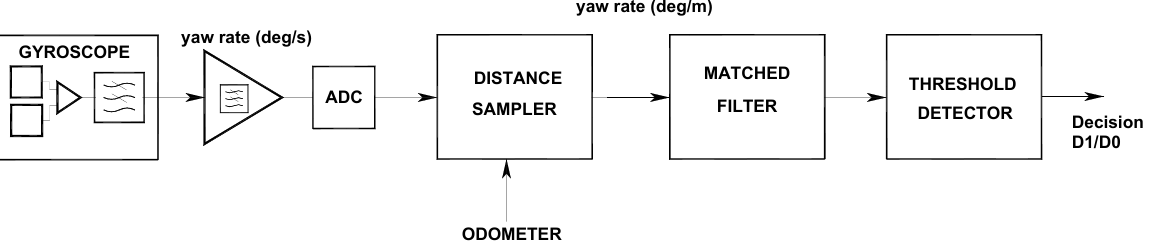
Figure 8. Gyroscope processing for robust track occupancy